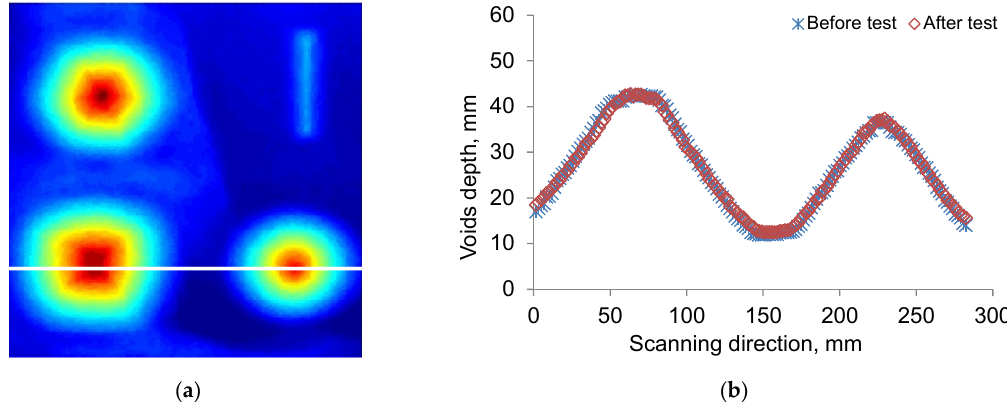
Figure 5. Change of void shapes using 5 MHz transducer for DB sand, ( a ): top view of detected four voids; and ( b ): section through two voids (cube left and half sphere right).